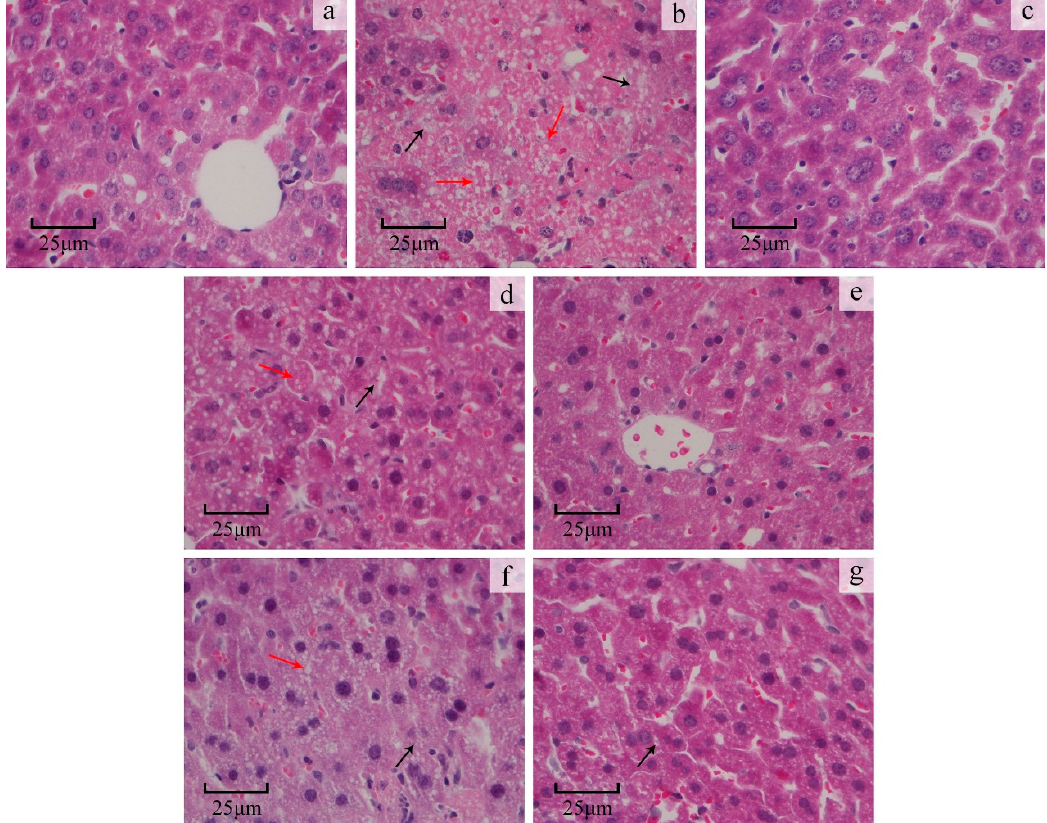
Figure 5. Effects of ORWP and ORAP on liver as disclosed by morphological analysis (×400 H&E staining). ( a ) normal control group; ( b ) CCl 4 -intoxicated group; ( c ) bifendate positive control group (200 mg/kg) + CCl 4 ; ( d ) ORWP (100 mg/kg) + CCl 4 ; ( e ) ORWP (200 mg/kg) + CCl 4 ; ( f ) ORAP (100 mg/kg) + CCl 4 ; ( g ) ORAP (200 mg/kg) + CCl 4 . Black arrows indicate necrotic zones; red arrows indicate lipid droplet accumulation.